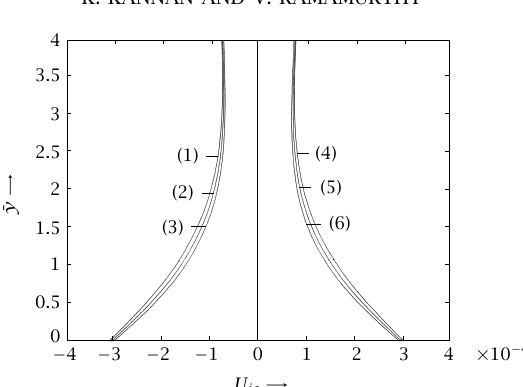
Figure 4.1 . Induced steady axial velocity component of the fluid U is in the boundary layer for R = 500, 4 = 0 . 05. (1) X = − 1, λ = 0 . 01, (2) X = − 1, λ = 0 . 16, (3) X = − 1, λ = 0 . 31, (4) X = 1, λ = 0 . 01, (5) X = 1, λ = 0 . 16, (6) X = 1, λ = 0 .